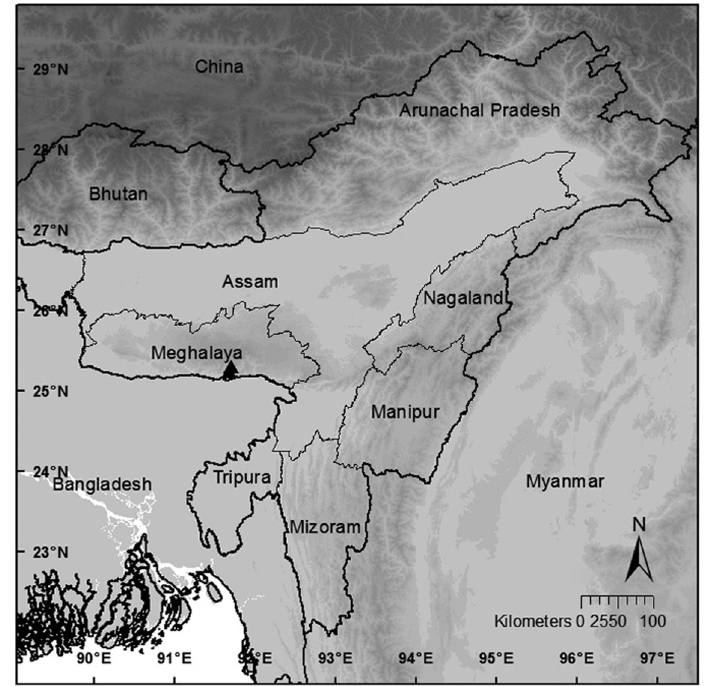
Fig. 14. Map showing the location of B. brevicaulis A.DC.